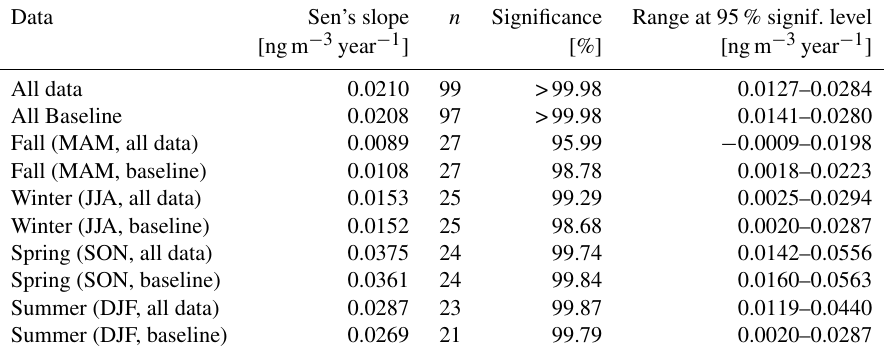
Table 1. Sen’s slopes calculated from monthly GEM averages of all and baseline (i.e., 222 Rn ≤ 250mBqm − 3 ) data for March 2007–June 2015.